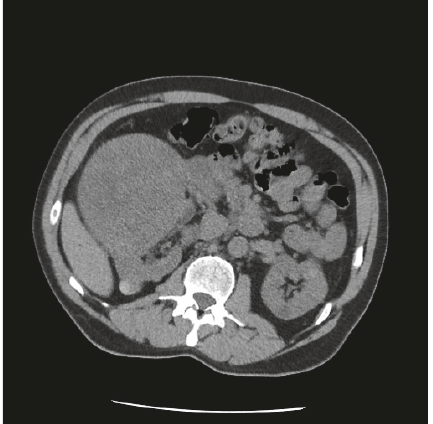
Figure 3: Computed tomography without contrast demonstrating left paraaortic mass, left interpolar renal mass, and large right renal mass.